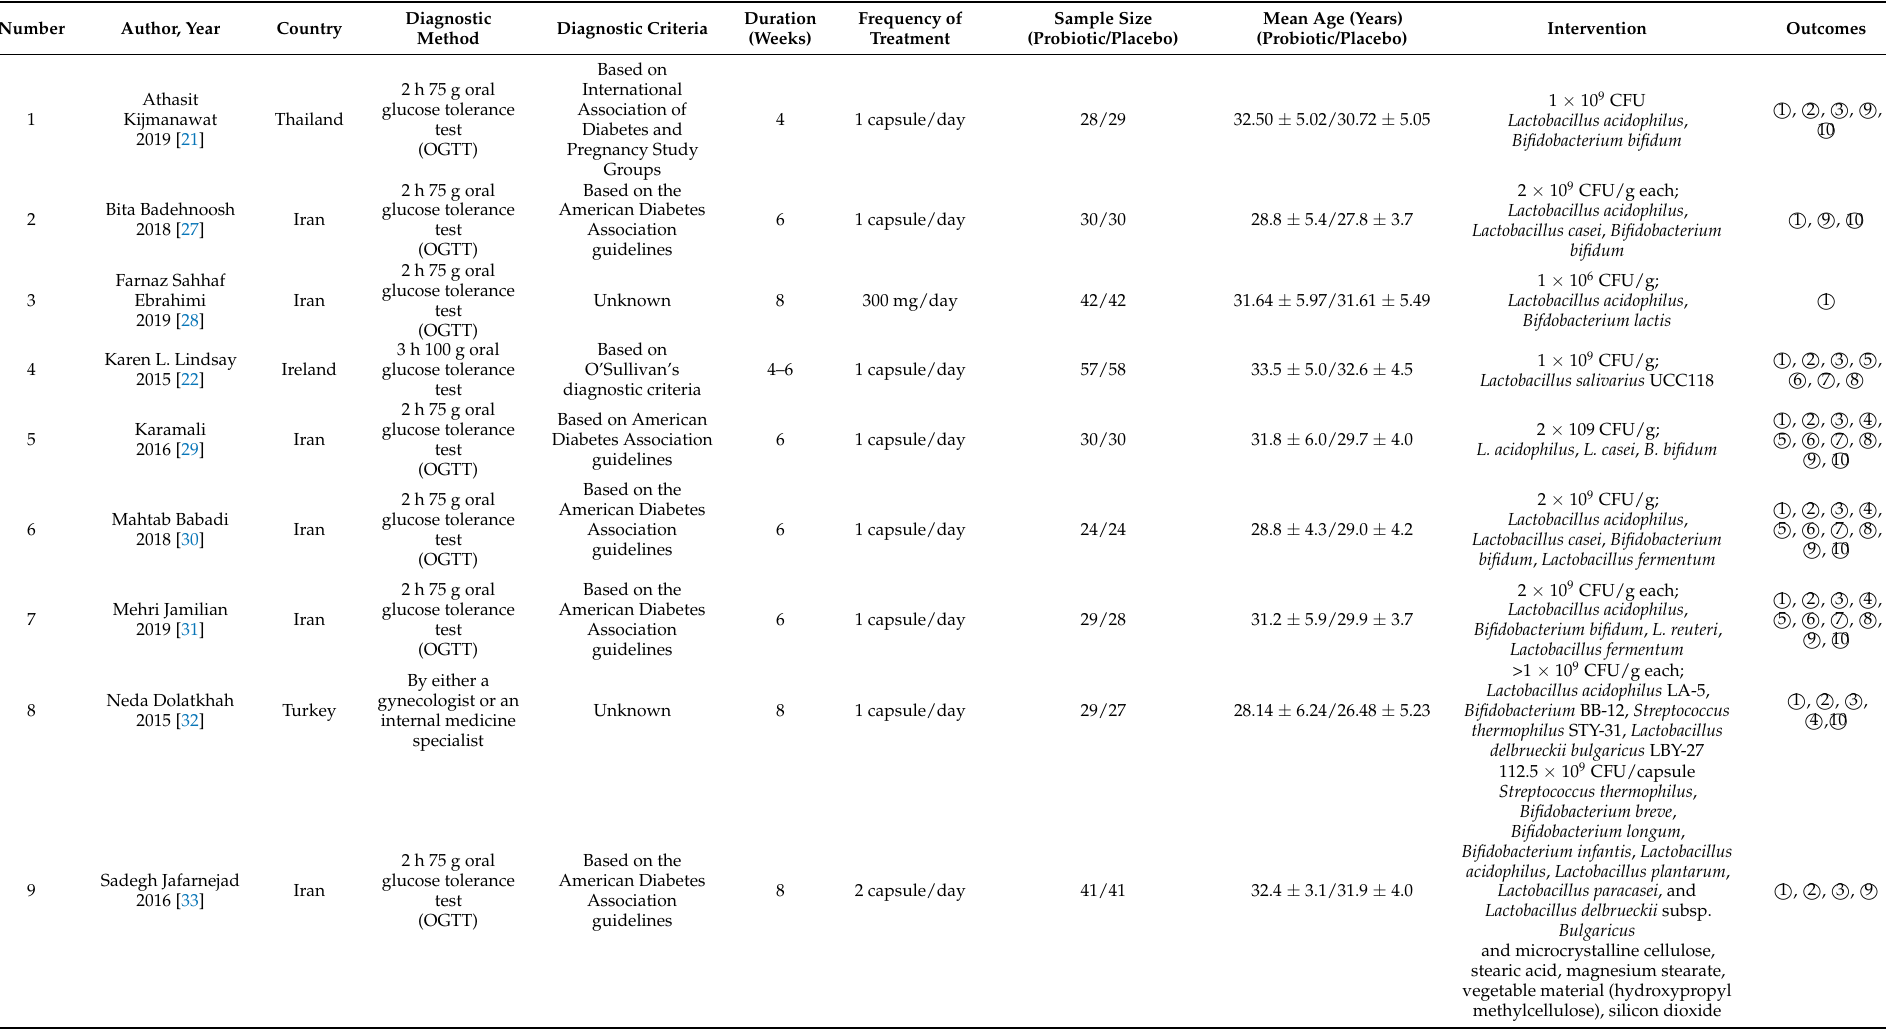
Table 1. Characteristics of included